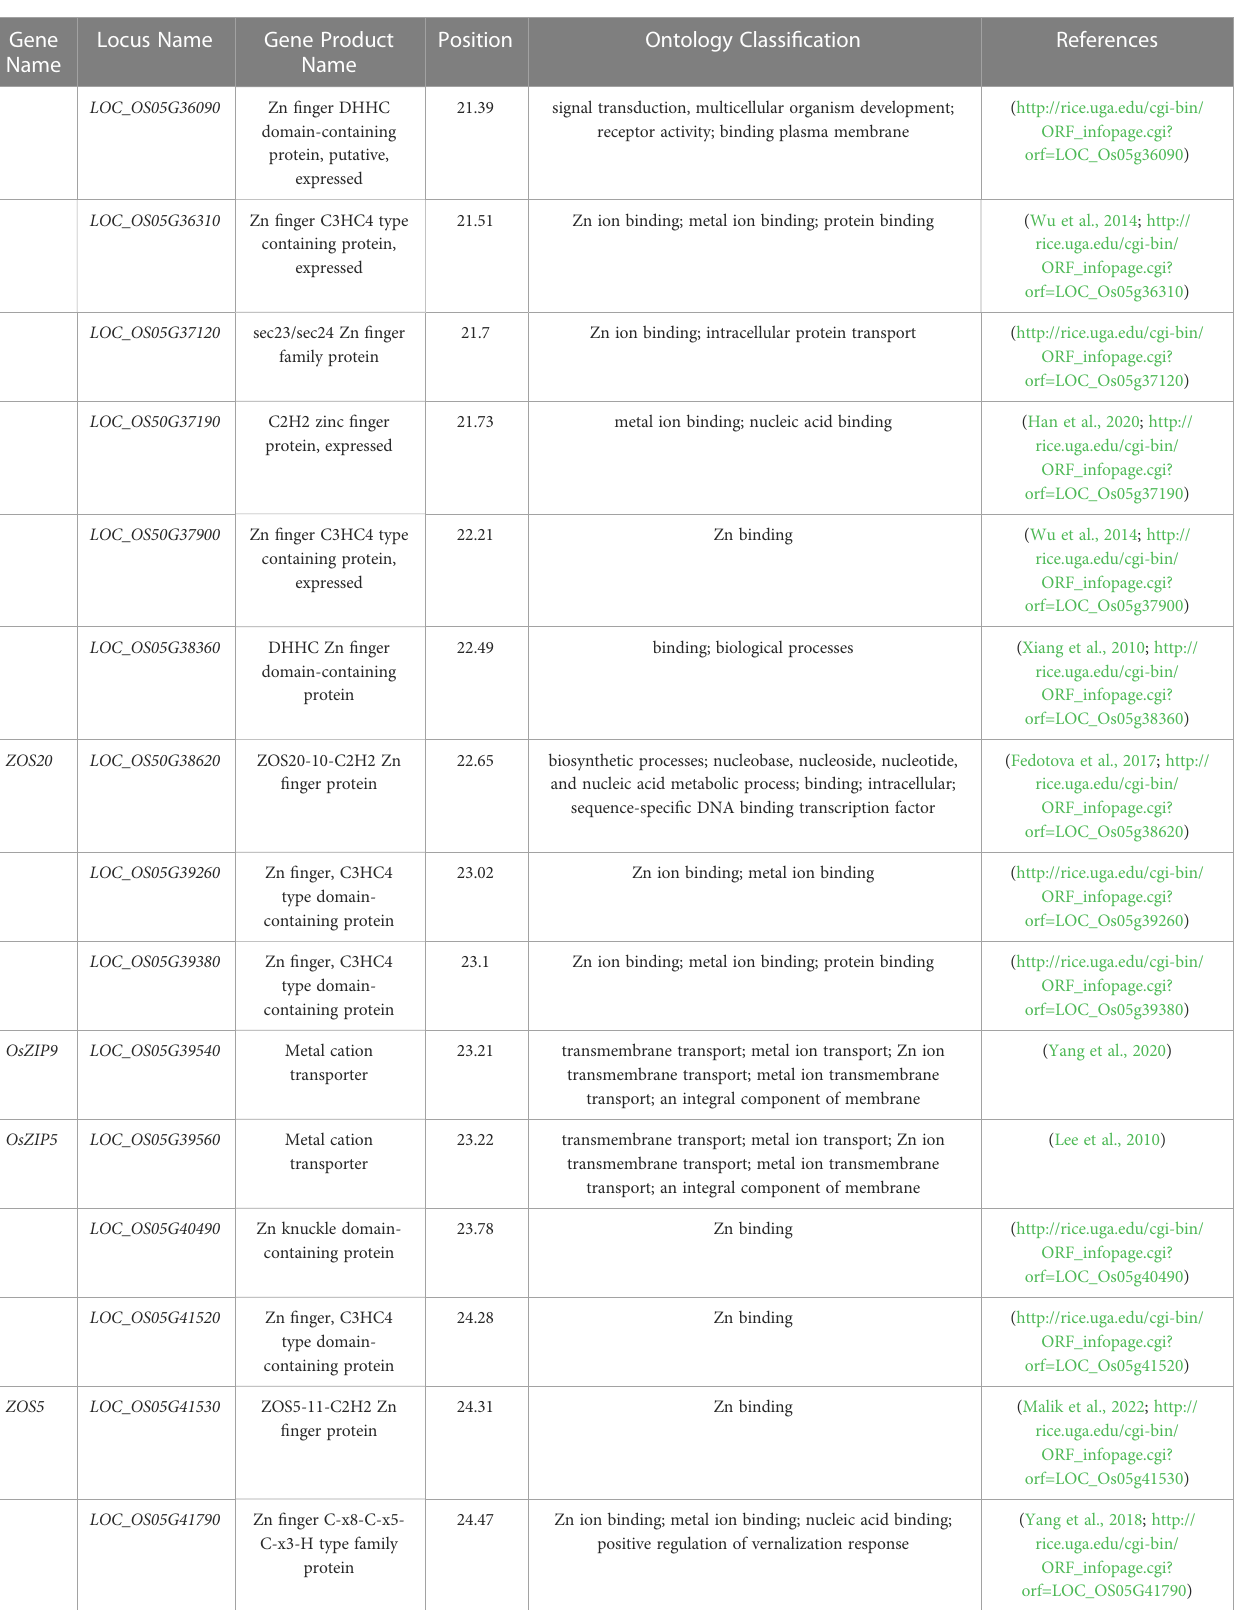
TABLE 4 Candidate genes for grain Zn concentration underlying the major QTL ( qZn 5.2